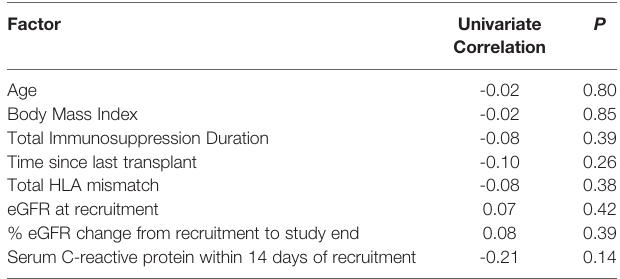
TABLE 2 | Univariate analysis of continuous variables and their association with mHLA-DRd in renal transplant recipients. Factor